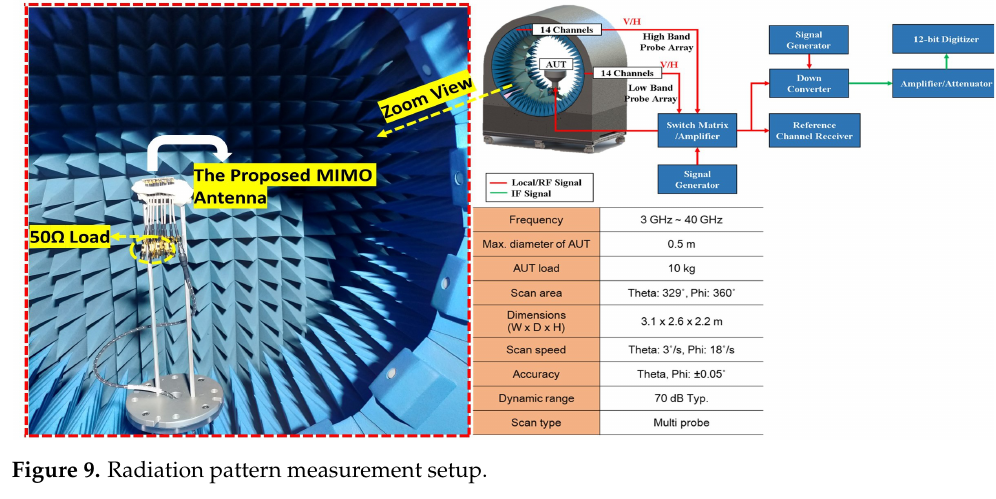
Figure 9. Radiation pattern measurement setup.